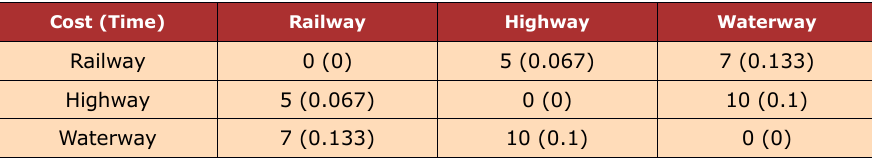
Table 3. Unit transshipping cost and time between the transportation